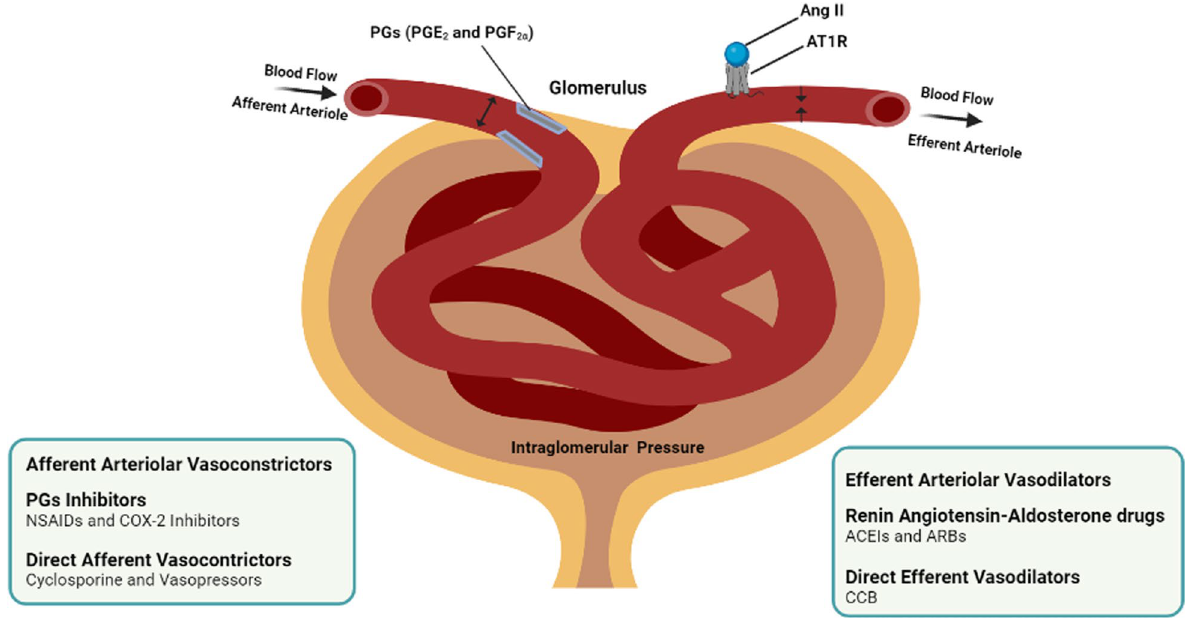
Fig. 3 How drugs alter renal perfusion, especially if co-administrated. Prostaglandins (PGs) cover the endothelium of afferent arteriole causing its vasodilation, while angiotensin-2 (Ang II) binds to angiotensin II receptor type 1 (AT1R) located in the efferent arteriole resulting in vasoconstriction. Non-steroidal anti-inflammatory drugs (NSAIDs), cyclooxygenase-2 (COX-2) angiotensin-converting enzyme inhibitors (ACEIs), angiotensin receptor blockers (ARBs), Calcium channel blockers (CCBs) [86, 87]. Figure created with